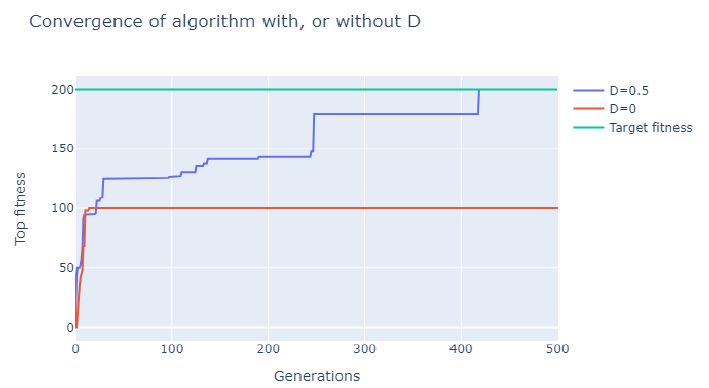
Figure 1. Effect of sub-parse variable on L 9